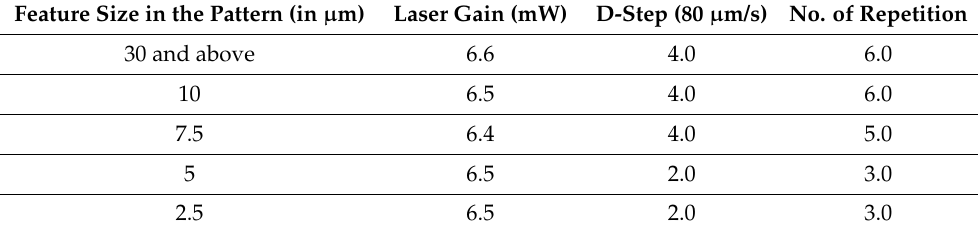
Table 2. Laser parameters optimized for HP-14.